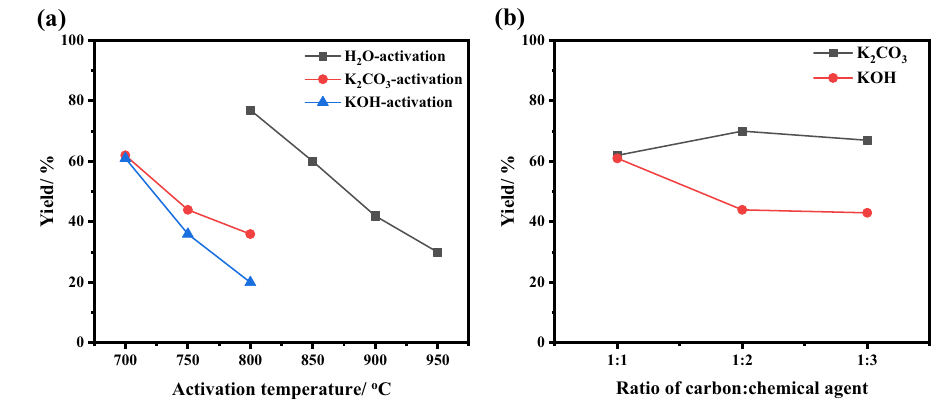
Figure 1. The calculated yield of activated carbon with various activators, water vapor, K 2 CO 3 , and KOH, at different temperatures ( a) and ratio of chemical agents ( b ) of BU_car